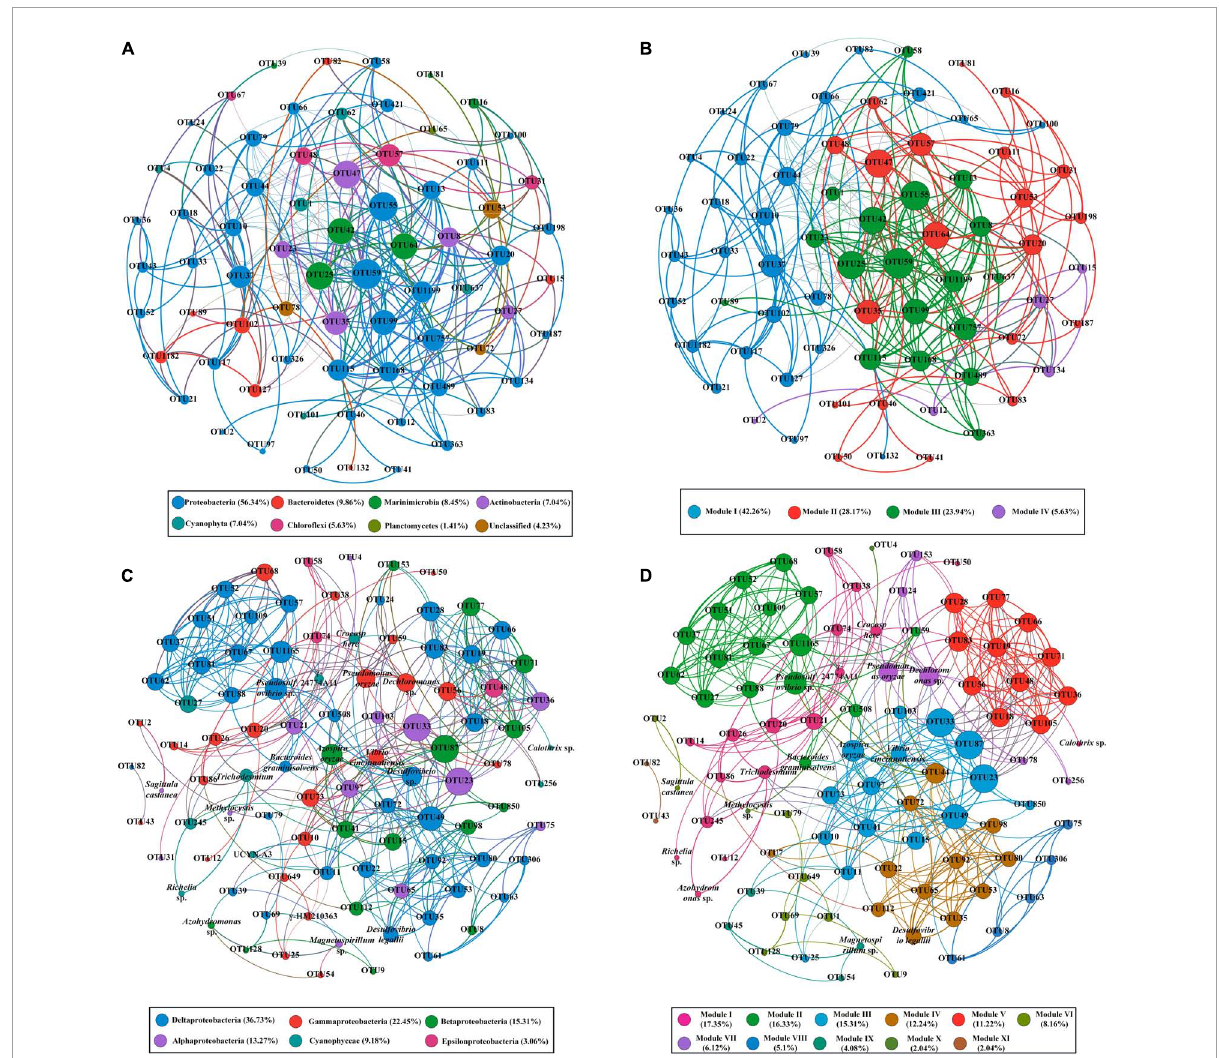
FIGURE5 The co-occurrence patterns of bacterial communities (A,B) and diazotroph communities (C,D) revealed by network analysis. Only statistically robust (| r | > 0.9 for bacterial communities and | r | > 0.7 for diazotroph communities) and significant ( P -value < 0.01) correlations were included in the further analysis. The nodes were colored according to different types of phylum (A,C) and modules (B,D) . The size of each node is proportional to the degree of nodes.